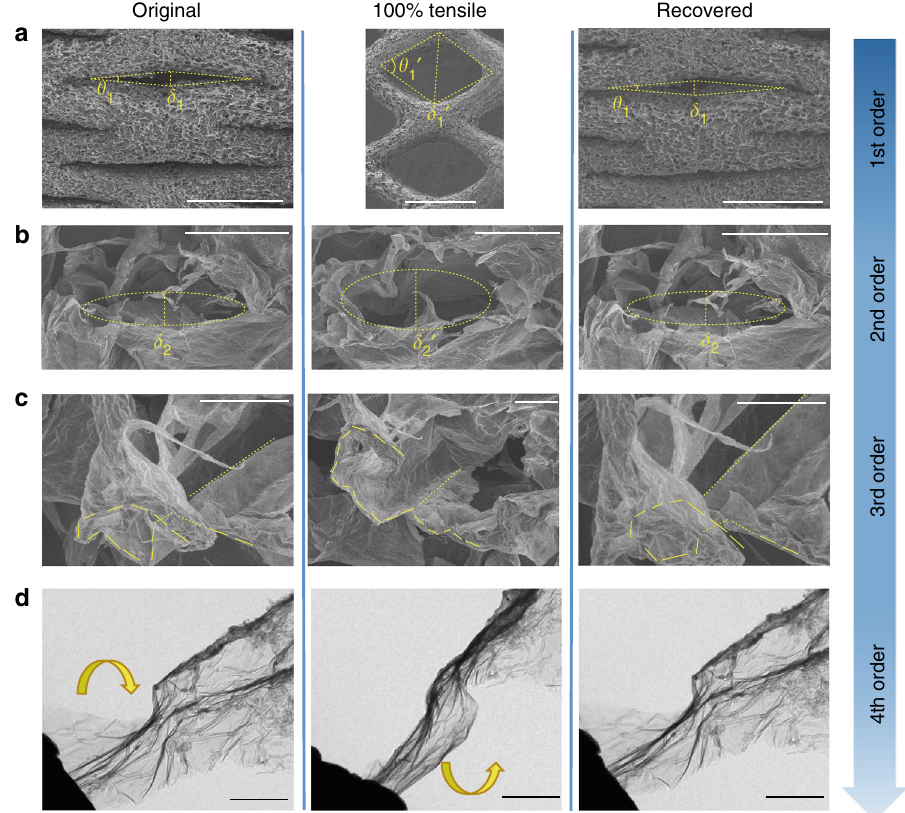
Fig. 5 The bCA exhibits recoverable tensile deformation in four orders of hierarchy. a – c In situ SEM tracking on structural evolution of each orders structure in one cycle. a The length (140 μ m, labeled by δ 1 ) was stretched to 770 μ m ( δ 1 ′ ) and recovered to 155 μ m. b The length of a cell (9.7 μ m, δ 2 ) was stretched to 17.6 μ m ( δ 2 ′ ) and recovered to 10.1 μ m. d In situ TEM observation of a binary laminate in one stretching-retraction cycle. Scale bars, 1 mm ( a ), 30 μ m ( b ), 10 μ m ( c ), and 100 nm ( d